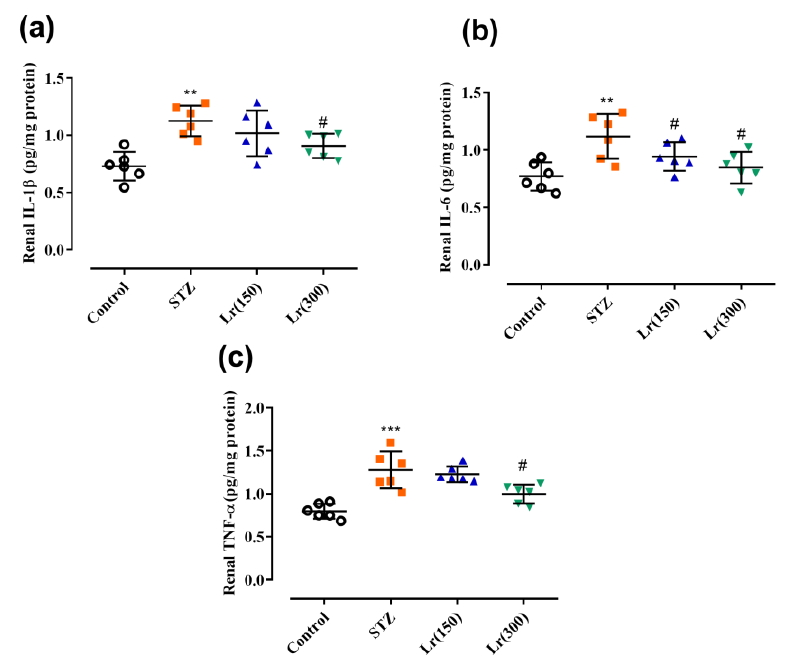
Figure 4. Effect of L. regularis (150 or 300 mg/kg for 4 consecutive weeks) on diabetic-induced changes in renal proinflammatory cytokines, including interleukin-1 β (IL-1 β ) ( a ), interleukin-6 (IL-6) ( b ) and tumor necrosis factor- α (TNF- α ) ( c ). Data are expressed as means ± SE ( n = 6) and were analyzed using one-way ANOVA followed by Student Newman–Keuls as post hoc test. * Control vs. STZ group; # STZ vs. L. regularis (150) or L. regularis (300). # p < 0.05, ** p < 0.01, *** p < 0.001.